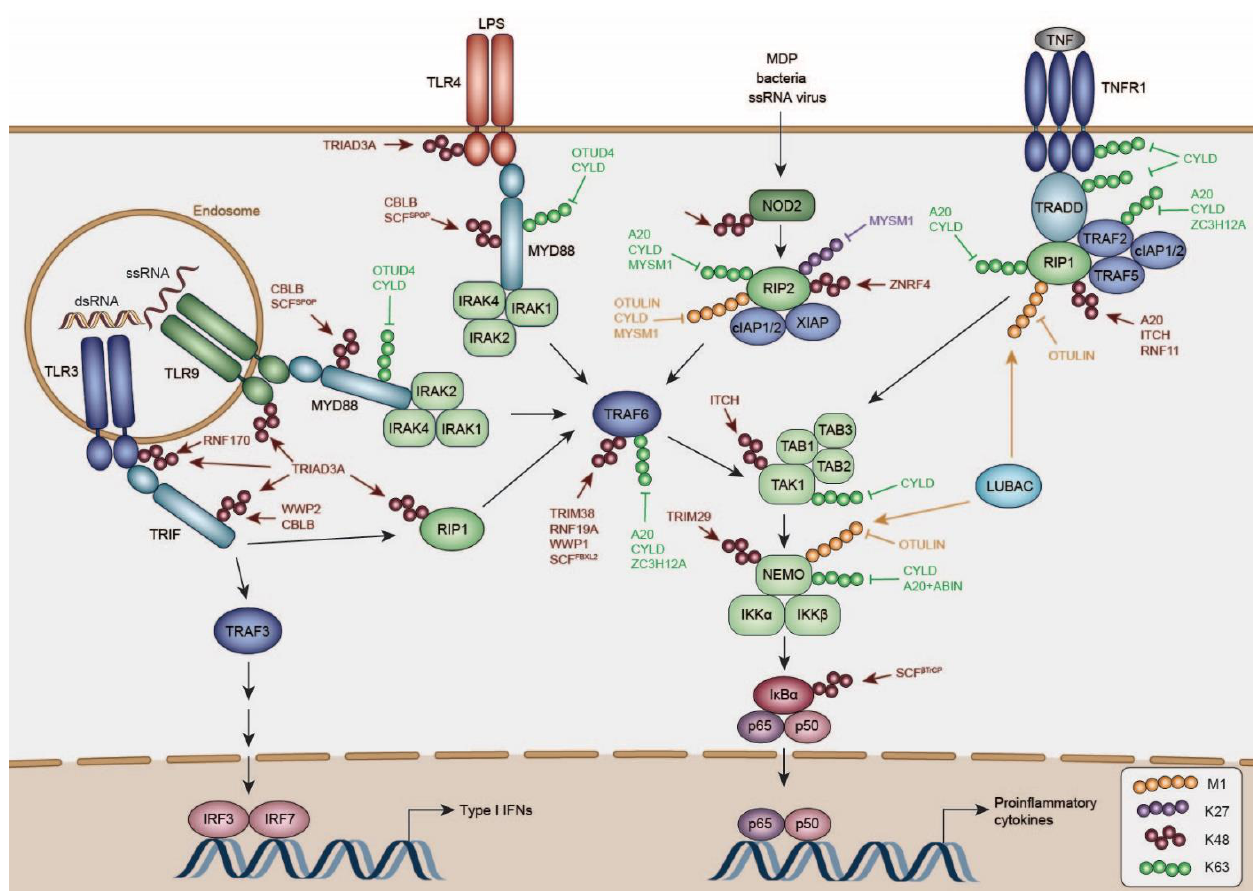
Figure 2. Negative regulation of Toll-like Receptor (TLR), Tumor Necrosis Factor (TNF), and Nucleotide Binding Oligomerization Domain (NOD)-like Receptor (NLR) pathways. ( left ) TLR3 recognizes dsRNA in endosomes, which results in activation of its adapter TRIF. TLR4 is expressed on the plasma membrane and recognizes lipopolysacharide (LPS), whereas TLR9 is expressed in endosomes of specialized myeloid cells, such as plasmacytoid dendritic cells (pDC), and recognizes single-stranded (ss)RNA. Activation of both of these TLRs activates the adapter Myeloid Differentiation 88 (MYD88). ( middle ) NOD2 recognizes bacterial peptidoglycans, thereby activating a complex of cellular Inhibitor of Apoptosis 1 (cIAP1)/cIAP2/ X-Linked Inhibitor of Apoptosis (XIAP). ( right ) Binding of TNF trimerizes its receptor, resulting in recruitment of Tumor Necrosis Factor Receptor Type 1 Associated Death Domain (TRADD), Receptor-Interacting Protein 1 (RIP1), TRAF2, TRAF5, cIAP1, cIAP2, and the Linear Ubiquitin Assembly Complex (LUBAC). All these pathways result in the activation of the TGF-Beta Activated Kinase 1 Binding (TAB)/ TGF-Beta Activated Kinase (TAK) and classic IKK kinase complexes , which activate NFκB. The IKKα/β/NEMO kinase complex phosphorylates IκBα, the inhibitor of NFκB, subsequently resulting in its degradation, and release of active NFκB. NFκB translocates to the nucleus, where it drives transcription of pro-inflammatory response genes. Poly-ubiquitin chains on each molecule are shown in different colors, depending on their linkage type: M1 (orange), K27 (purple), K48 (dark red), K63 (green). Names of DUBs removing activating K63 poly-ubiquitin chains are listed in green, K27 chains in purple, and M1 chains in orange. E3 ligases adding degradative K48 chains are displayed in dark red.